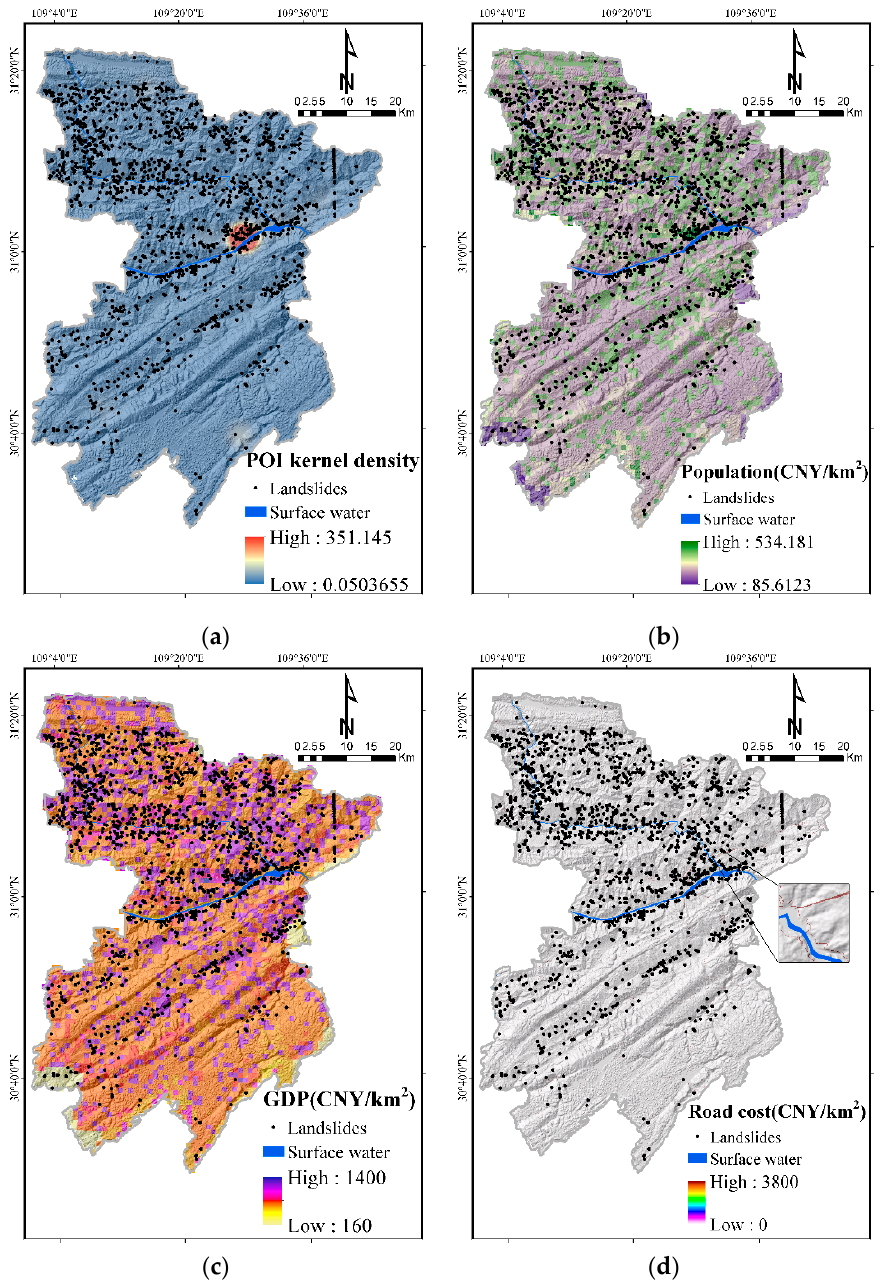
Figure 7. Influence Factors on Layer of Landslide vulnerability: ( a ) POI kernel density; ( b ) Population; ( c ) GDP; ( d ) Road cost.